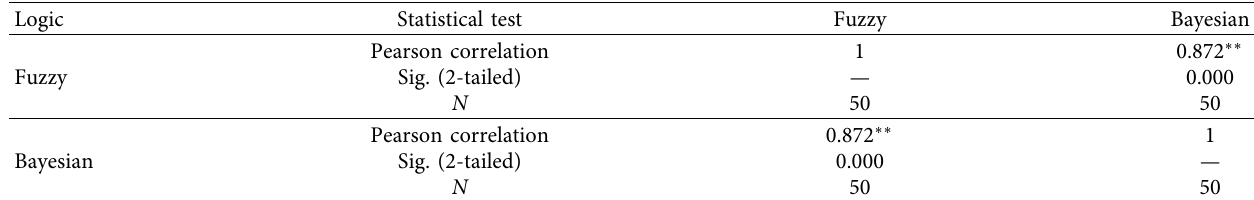
Table 11: Output correlation table of the two